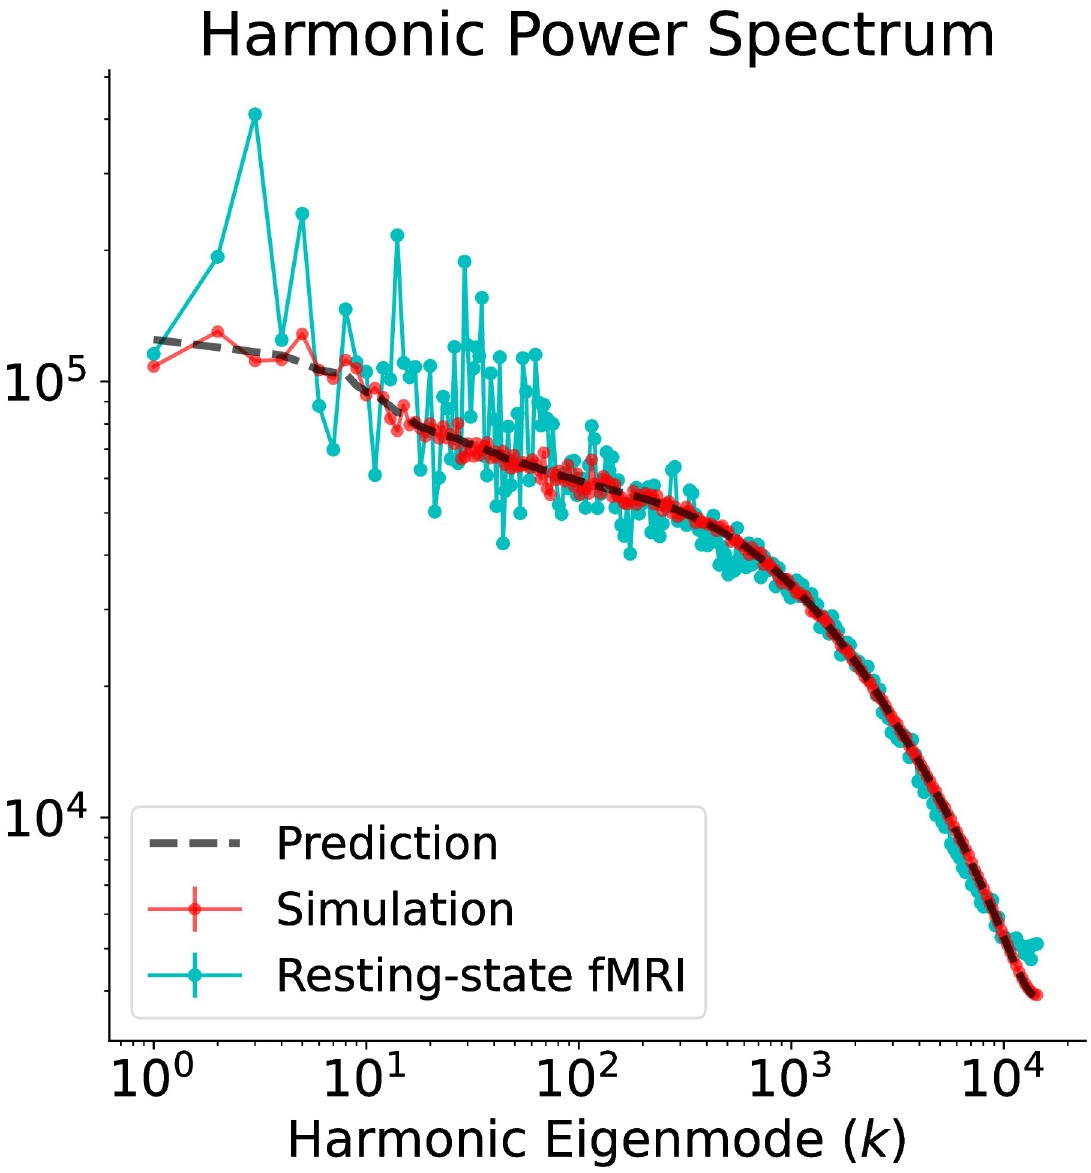
Fig 5. Stochastic Wilson-Cowan graph neural field model captures the resting-state fMRI harmonic power spectrum. The theoretical (dashed black line) and numerical (red line) predictions from the stochastic Wilson-Cowan graph neural field model, with the parameters of S2 Table, are in excellent agreement with the empirically observed fMRI harmonic spectrum (cyan line). The numerical spectrum was obtained by taking the median of three independent simulations.